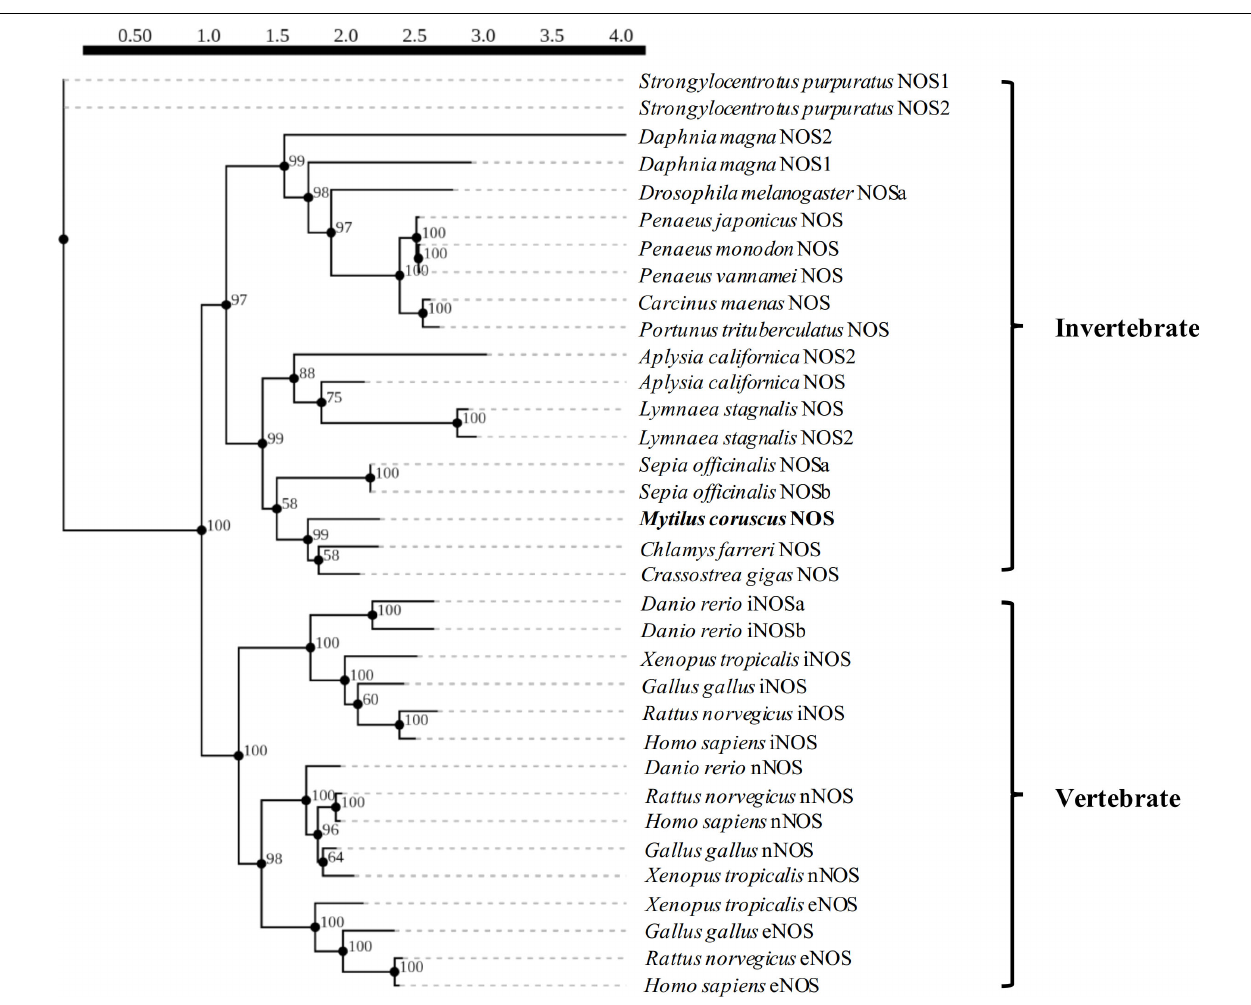
FIGURE 5 | Phylogenetic analysis of amino acid sequences of M. coruscus NOS and other invertebrate and vertebrate NOS proteins. The phylogenetic tree was constructed using the ML method with PhyML software. GenBank accession numbers of proteins are the same as those in Figure 5 , accompanied by S. purpuratus NOS1 (XP_003729305.1), D. magna NOS2 (ACQ55299.1), D. magna NOS1 (ACQ55298.1), P. japonicus NOS (BAI67609.1), P. monodon NOS (ACJ54486.1), P. vannamei NOS (ADD63793.1), C. maenas NOS (ACY56317.1), P. trituberculatus NOS (AMV91694.1), A. californica NOS2 (AAK92211.3), L. stagnalis NOS (AAC17487.1), L. stagnalis NOS2 (AAW88577.1), S. officinalis NOSa (AAS93626.1), S. officinalis NOSb (AAS93627.1), D. rerio iNOSa (NP_001106973.1), D. rerio iNOSb (NP_001098407.1), D. rerio iNOSb (NP_001098407.1), D. rerio nNOS (NP_571735.1), X. tropicalis iNOS (XP_002935342.1), X. tropicalis nNOS (XP_002938130.2), X. tropicalis eNOS (ACV74251.1), G. gallus iNOS (NP_990292.1), G. gallus nNOS (XP_425296.2), G. gallus eNOS (AFD20677.1), R. norvegicus iNOS (AAC13747.1), R. norvegicus nNOS (AAA62405.1), Rattus norvegicus eNOS (NP_068610.1), H. sapiens iNOS (NP_000616.3), H. sapiens nNOS (NP_000616.3), and H. sapiens eNOS